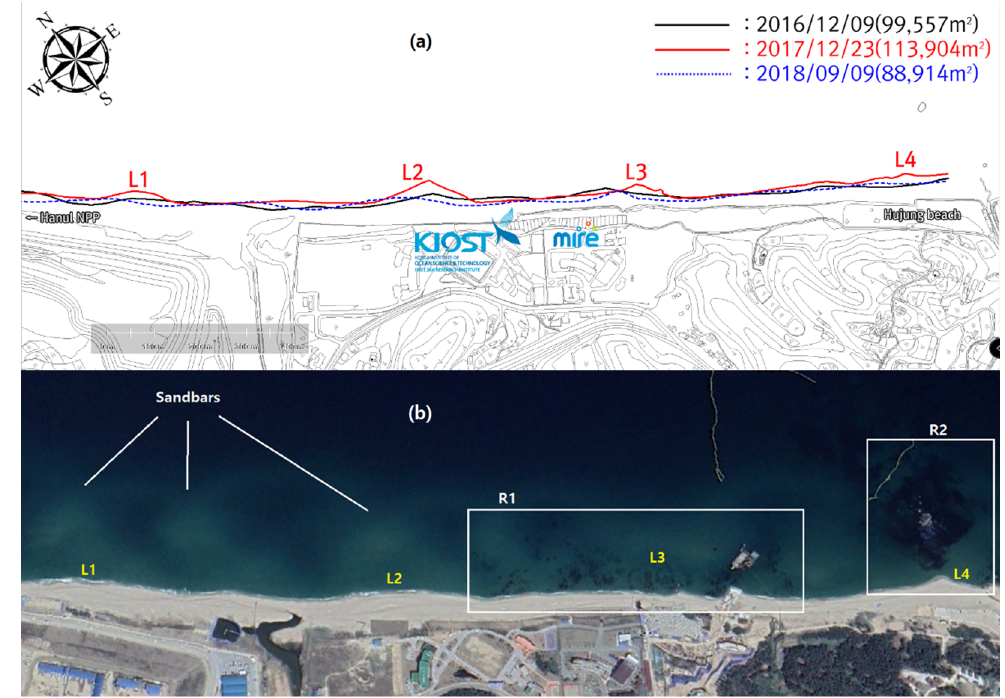
Figure 5. ( a ) Comparison of shoreline positions, (cid:1877) (cid:3047) , measured on 9 December 2016 (start date of data collection), 23 December 2017 (when (cid:1827) (cid:3029) became maximum at T3), and 9 September 2018 (when (cid:1827) (cid:3029) was minimum at T4). L1, L2, L3, and L4 denote the locations where the shoreline positions, (cid:1877) (cid:3047) , significantly changed during the period. ( b ) Satellite image on 20 April 2018 (T4), captured from Google Earth. The white rectangles, R1 and R2, denote the locations where underwater rocks develop near L3 and L4, respectively. The figure also shows the development of nearshore sandbars, indicated with the white